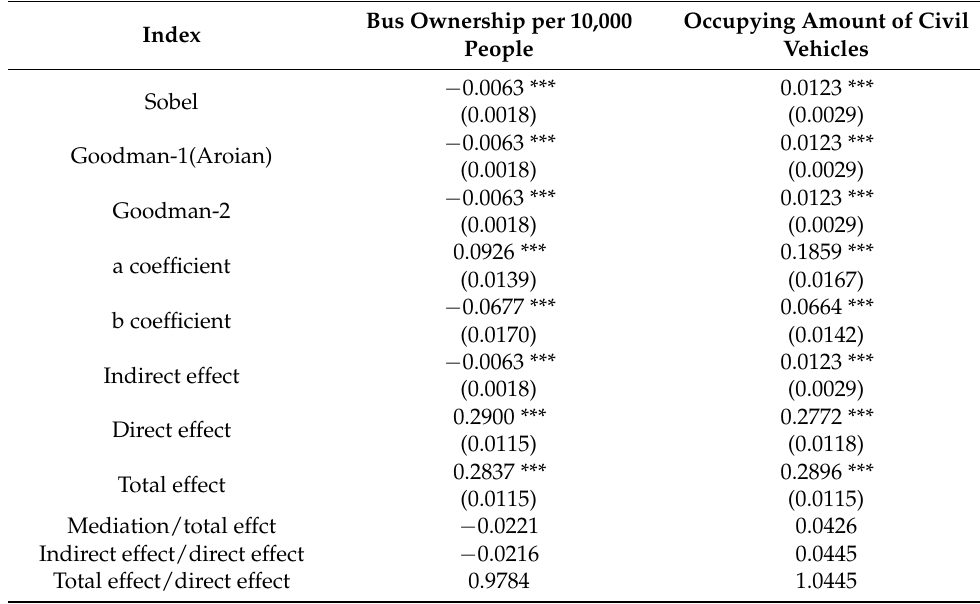
Table 4. Mesomeric Effect of Urban Population Agglomeration on Haze. The first line is the name of the measured index, and the last two lines represent the results of the Sobel test when Bus Ownership per 10,000 people or Occupying Amount of Civil Vehicles are used as proxy or mediator variables,